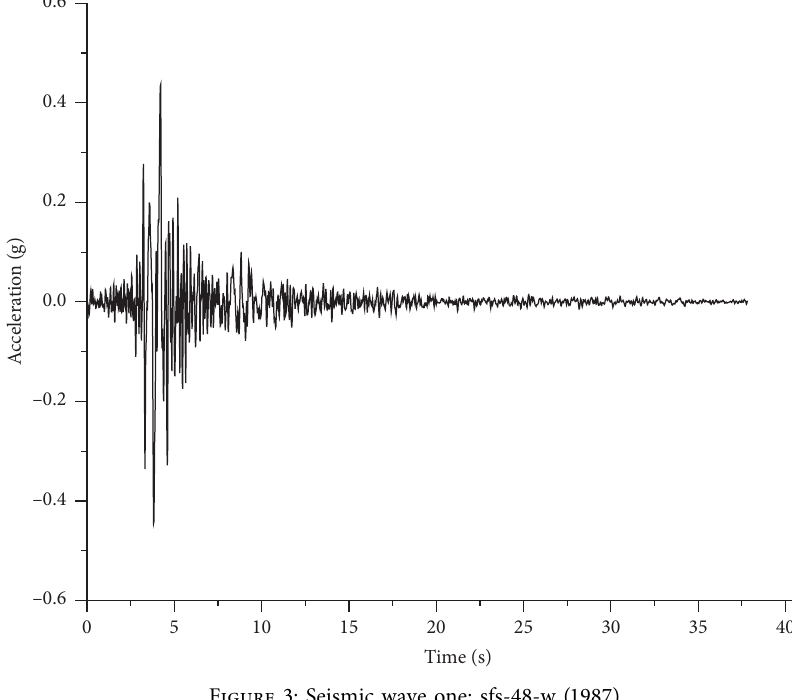
Figure 3: Seismic wave one: sfs-48-w (1987).